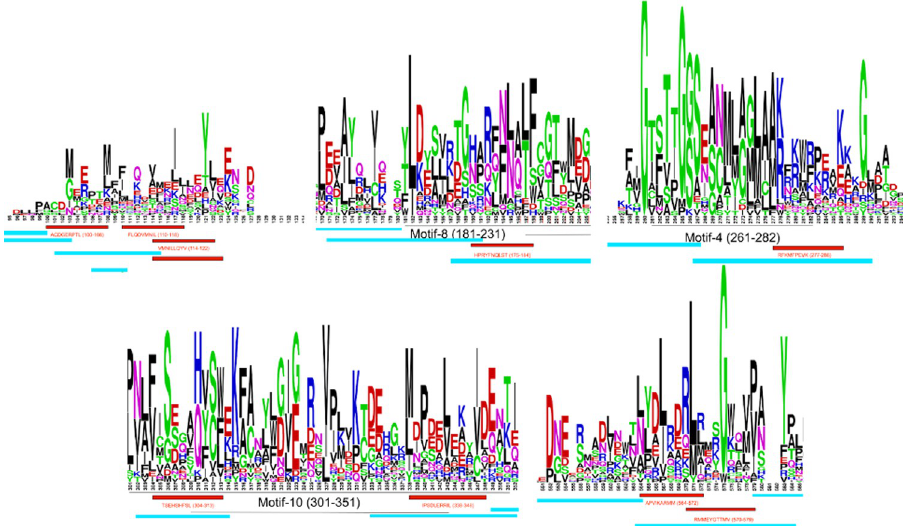
Fig 3. Conserved regions of GAD share common CD8+ and CD4+ T cell receptor epitopes. A total of 5 regions of interest were identified by overlapping T cell receptor epitopes to the sequence logo of 3 representative bacterial GAD and 3 animal GAD65 proteins. Three regions contained a motif match to Group II pyridoxal-dependent decarboxylases. The red and blue bars correspond to CD8+ and CD4+ T cell receptor epitopes, respectively. The black bars correspond to motif blocks with the motif numbers present in Fig 2. The first and last regions did not have any functional motifs, but they overlap with receptor epitopes. Of the amino acids in which both CD4+ and CD8+ receptor epitopes overlap, at least 1 amino acid residue is conserved across bacterial GAD and GAD65. Red is CD8+ epitopes, and Blue is CD4+ epitopes.